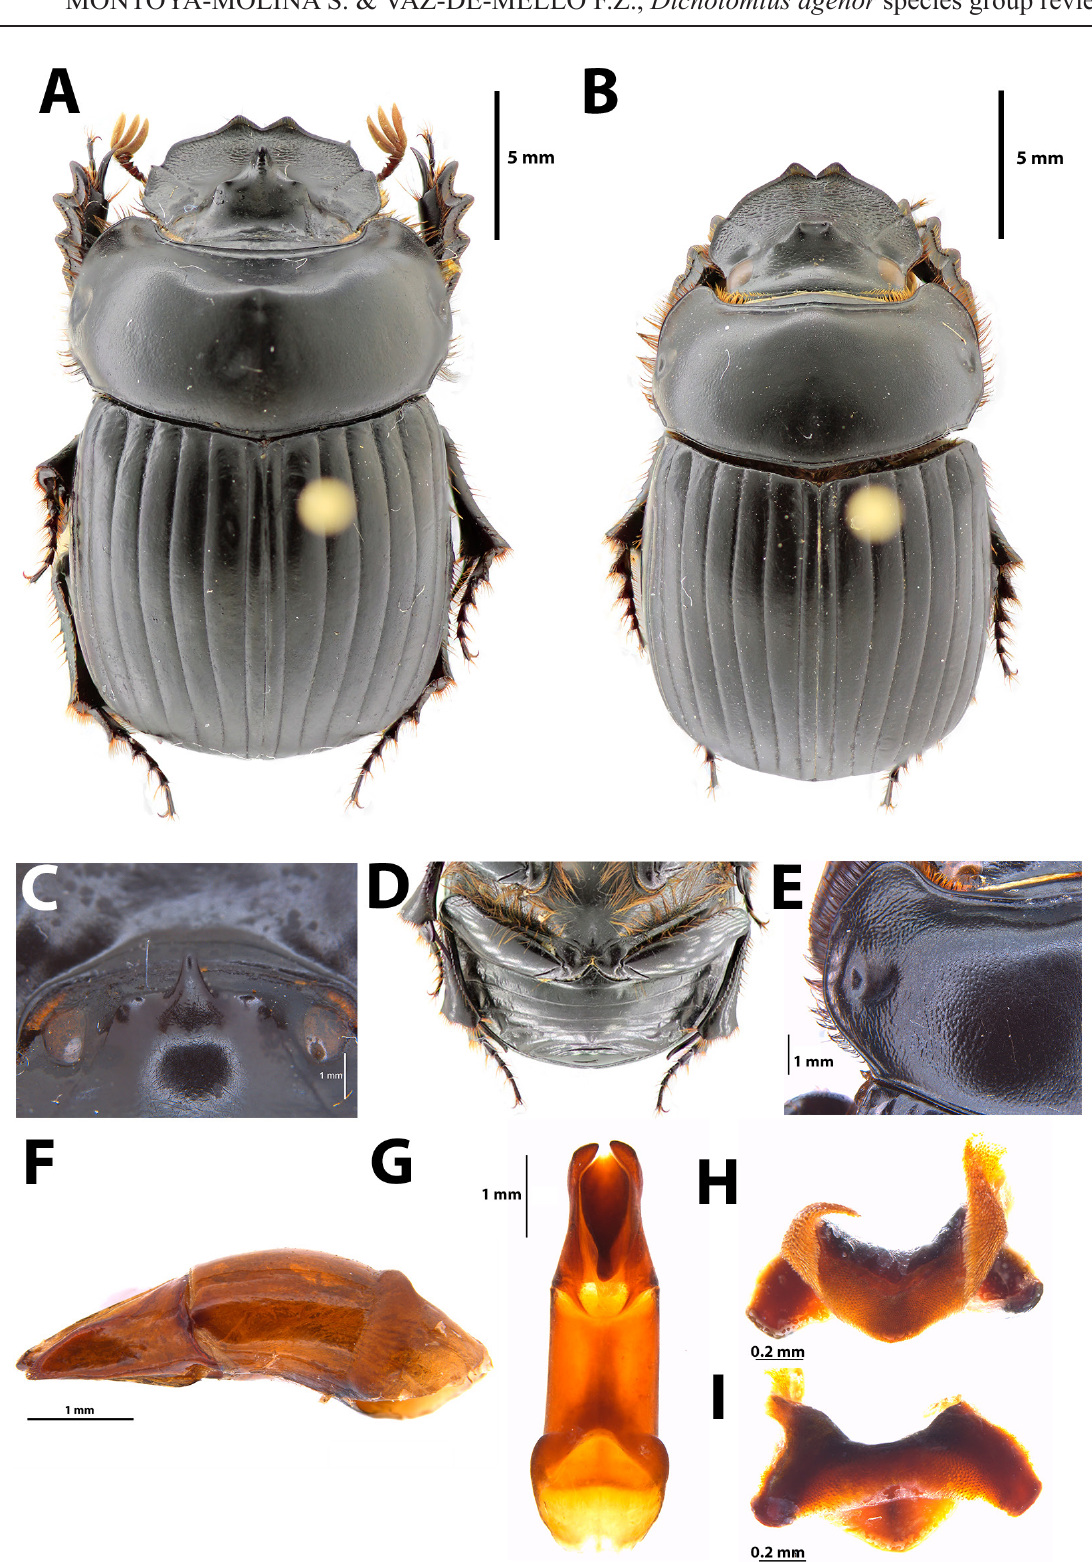
Fig. 11. Dichotomius inachoides (Felsche, 1901). A–B . Dorsal habitus. A . ♂. B . ♀. C . Frontal view of the head showing the male cephalic carina. D . Sternites smooth, lacking ocellate punctation. E . Female antero-lateral edge of the pronotum rugose. F . Lateral view of the aedeagus. G . Ventral view of the aedeagus. H–I . Lamella